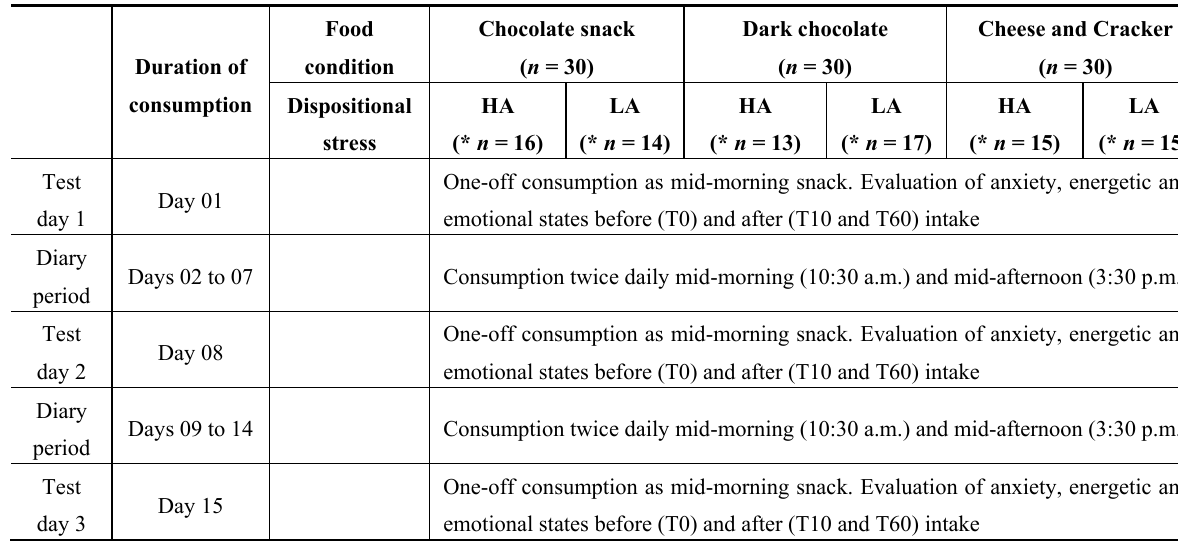
Table 1. Outline of the study